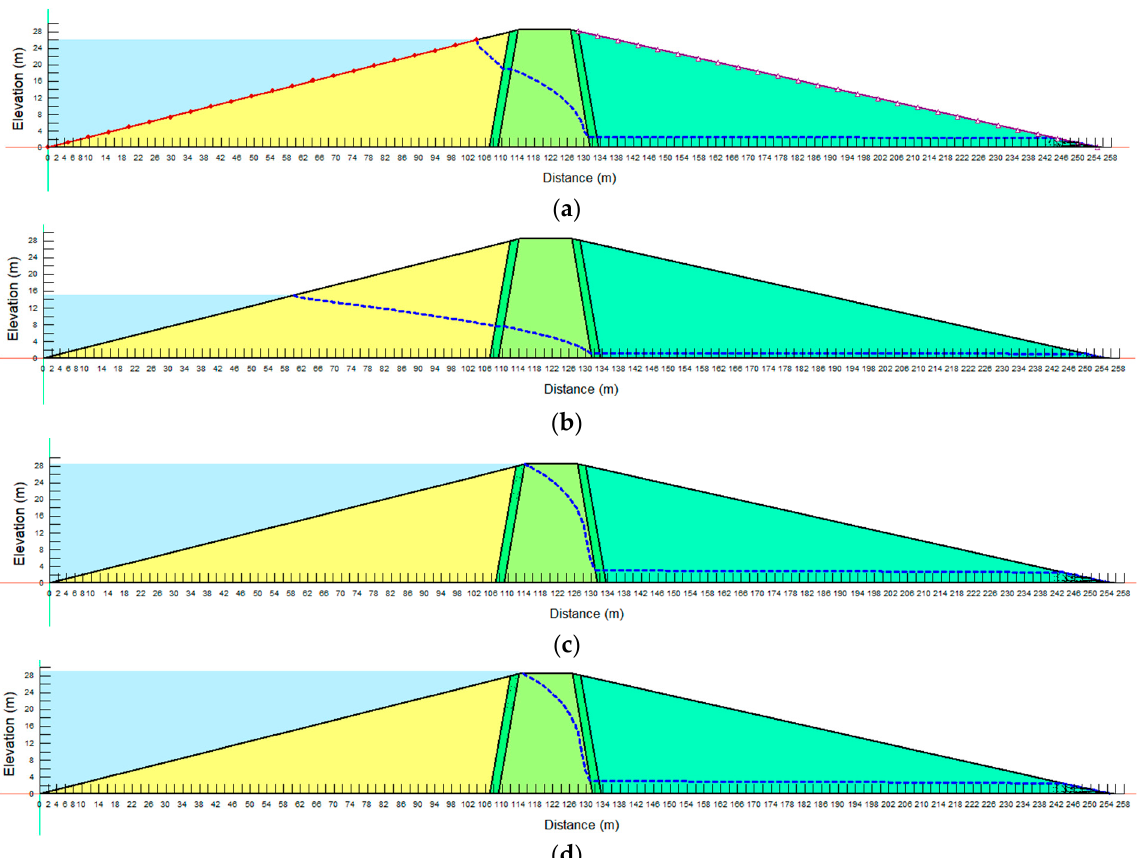
Figure 4. Steady-state seepage: ( a ) normal operating reservoir level, ( b ) reduced operating level, ( c ) embankment height level, ( d ) overflow level.